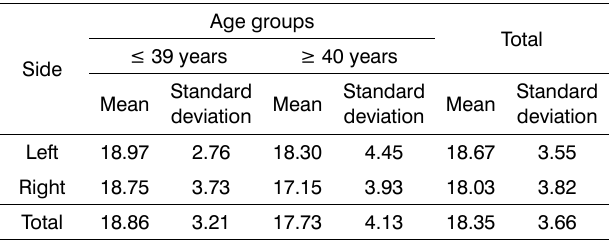
Table 8. Measurement 5 relative to age group and side, in mm, expressed as the mean ± standard deviation: